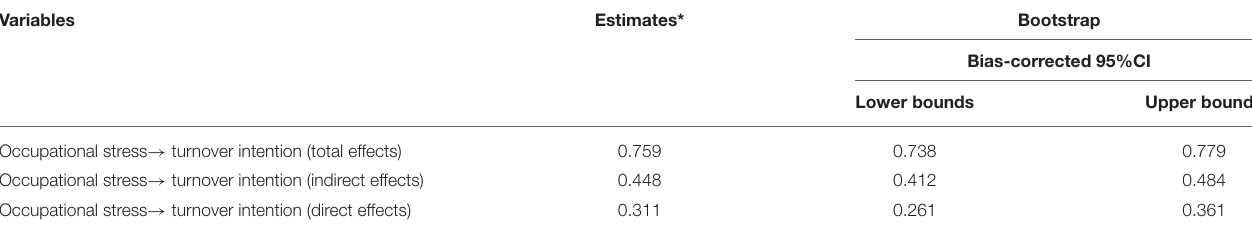
TABLE 4 | Mediating role of job satisfaction on the associations between occupational stress and turnover